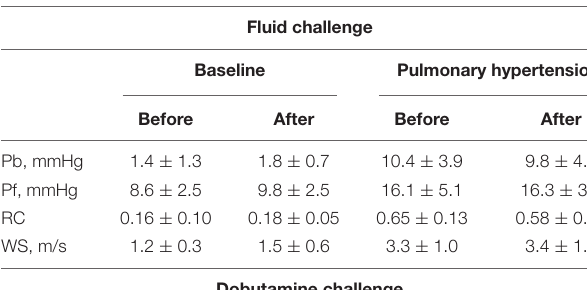
TABLE 2 | Effects of hemodynamic manipulations on